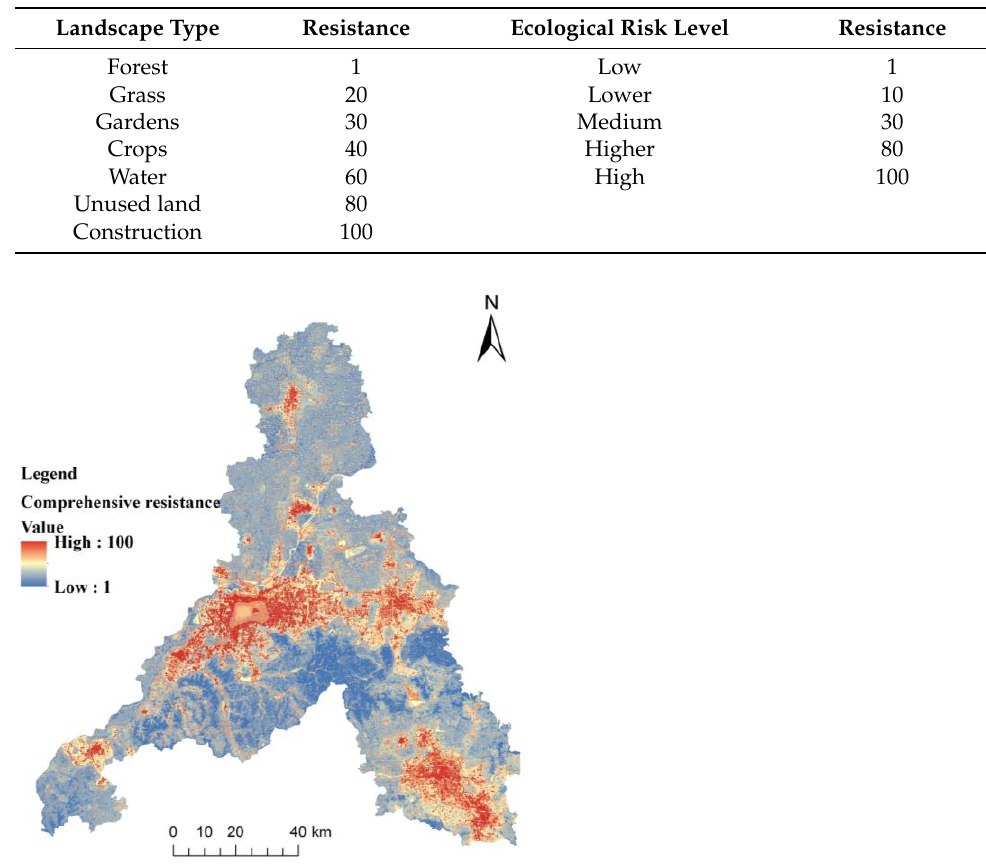
Table 4. Landscape type and ecological risk index assignment table.